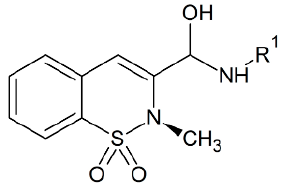
Figure 5. Chemical structure of the oxicam nucleus.